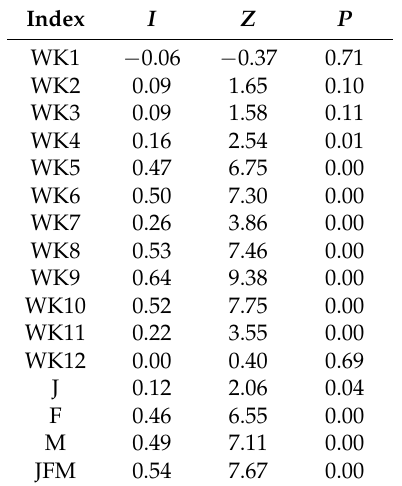
Table 5. Global index of spatial